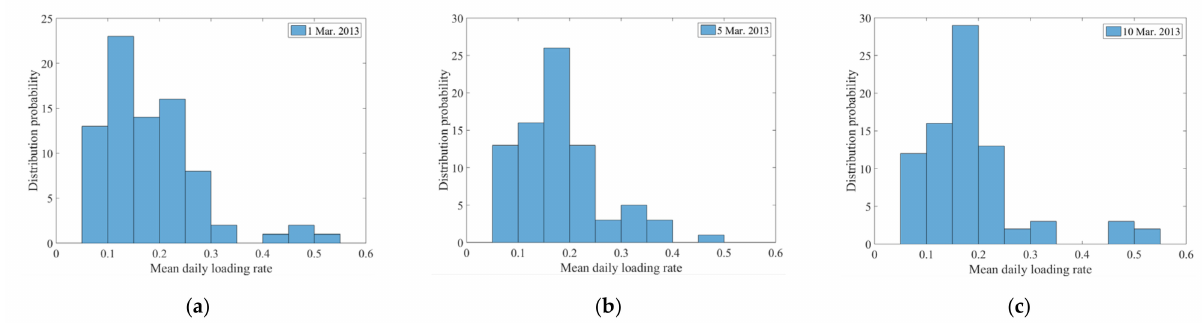
Figure 3. The distribution probability of mean daily loading rates of eighty selected customers: ( a ) 1 March; ( b ) 5 March; ( c ) 10 March.